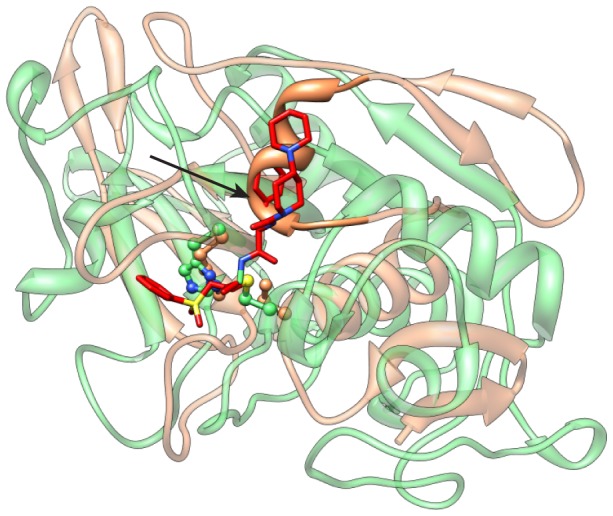
Structure alignment of T. brucei C51 model (TbC51m) with a distant structure homolog, human Cathepsin F (CatF).The superposition shows these two proteins have some general, overall structural similarities, but also large differences near the active site. The TbC51 model is colored in light orange, and the human CatF is in light green. While the catalytic Cys-His dyads are closely superimposed (depicted in ball-and-stick), a striking difference is marked by an arrow indicating the predicted steric clash between the CatF vinyl sulfone inhibitor (red) and the helix of TbC51 that partially obstructs the active site.